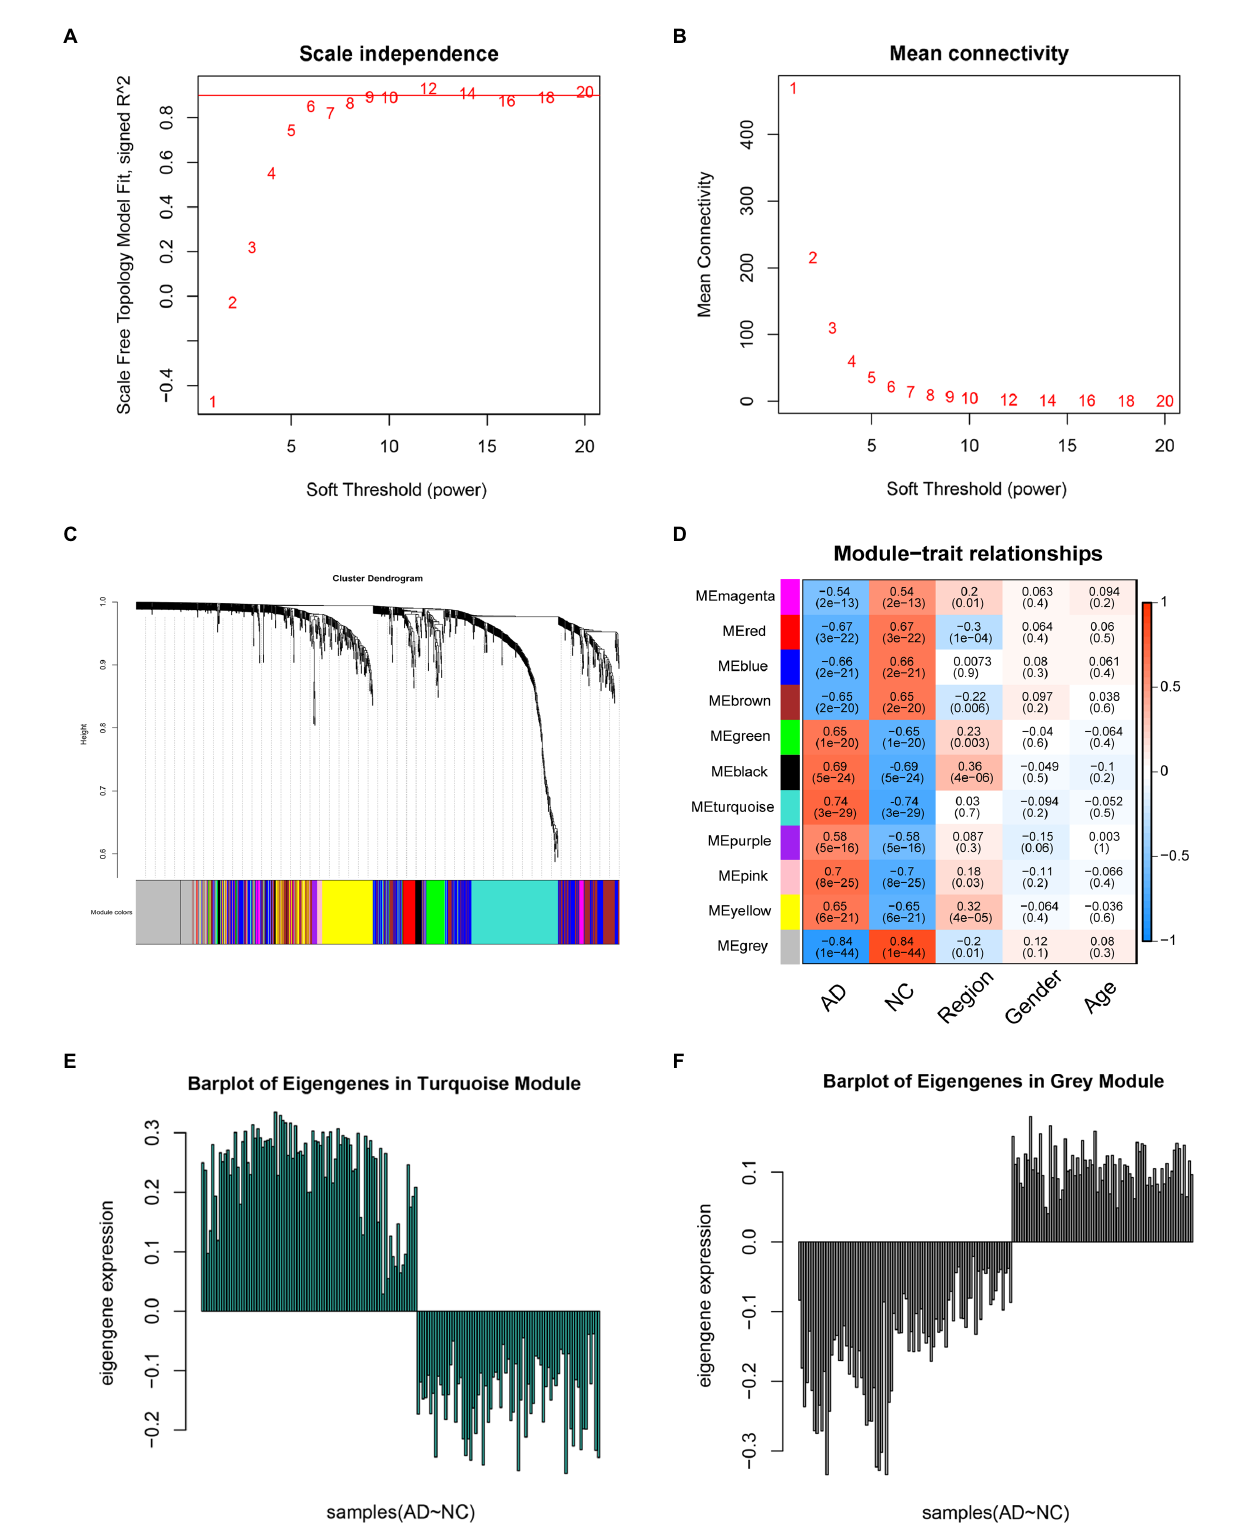
FIGURE 3 Weighted gene co-expression network analysis. (A) Analysis of the scale-free fit index for various soft-thresholding powers ( β ). (B) Analysis of the mean connectivity for various soft-thresholding powers. (C) Clustering dendrogram. (D) Module-trait associations as evaluated by correlations between module eigengenes and clinical traits; turquoise module represents a positive correlation with the clinical traits, whereas gray modules represents a negative correlation with the clinical trait. In each module, the top number represents the correlation and the bottom number represents the p -value. (E) Barplot of eigengenes in turquoise module. (F) Barplot of eigengenes in gray